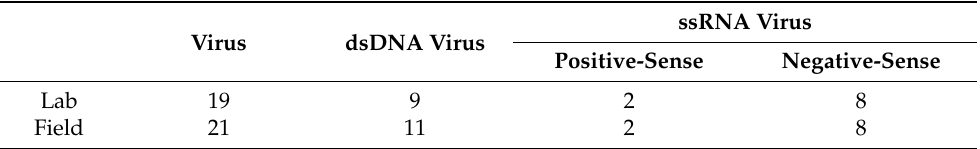
Table 1. Number of viral RNA fragments found in the transcriptome of pheromone gland in two populations. ssRNA Virus Virus dsDNA Virus Positive-Sense Negative-Sense Lab 19 9 2 8 Field 21 11 2 8